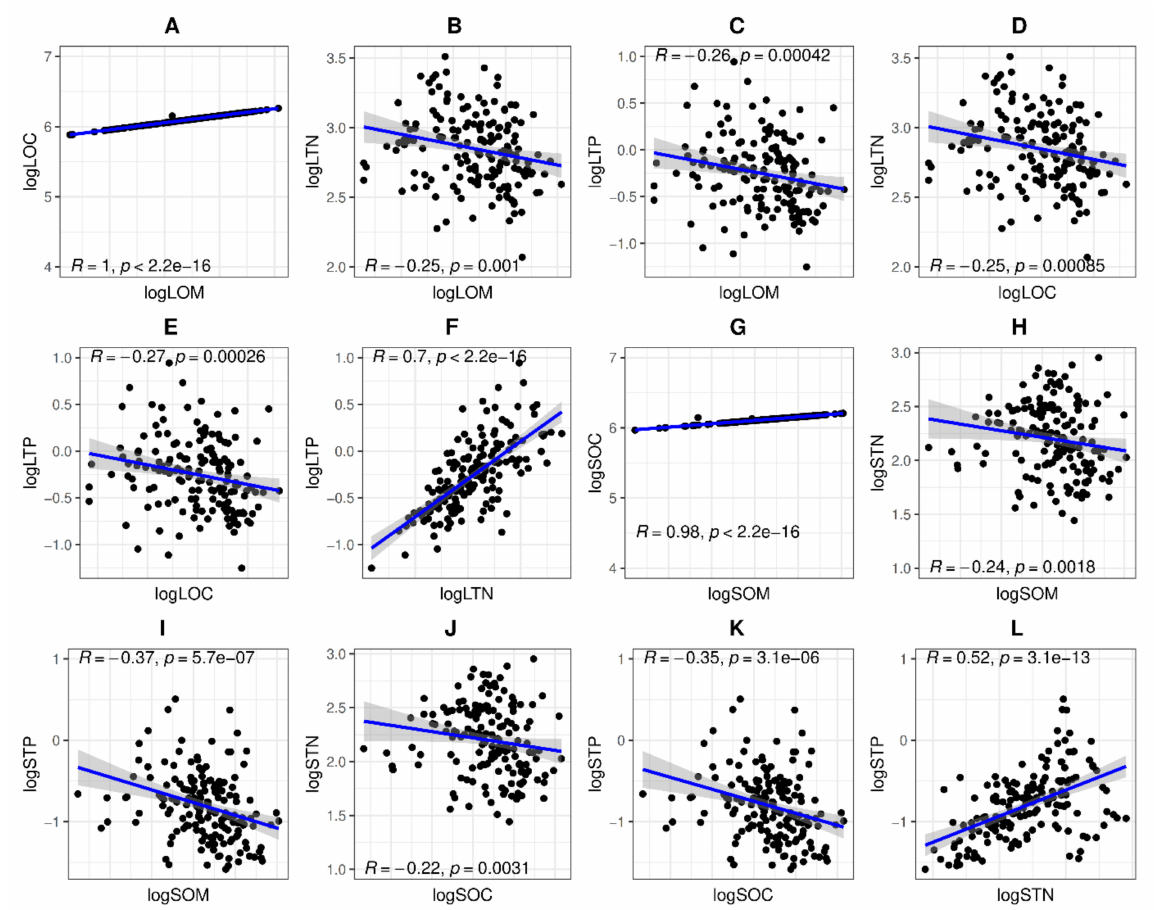
Figure 5. The associations between nutrient functional attributes of woody tree species’ aboveground vegetative parts in the tropical coastal secondary forest. LOC, LOM, LTN, LTP, SOC, SOM, STN, STP, and concentration. Showed the relationship between ( A ) logLOC and logLOM, ( B ) logLTN and logLOM, ( C ) logLTP and logLOM, ( D ) logLTN and logLOC, ( E ) logLTP and logLOC, ( F ) logLTP and logLTN, ( G ) logSOC and logSOM, ( H ) logSTN and logSOM, ( I ) logSTP and logSOM, ( J ) logSTN and logSOC, ( K ) logSTP and logSOC, ( L ) logSTP and